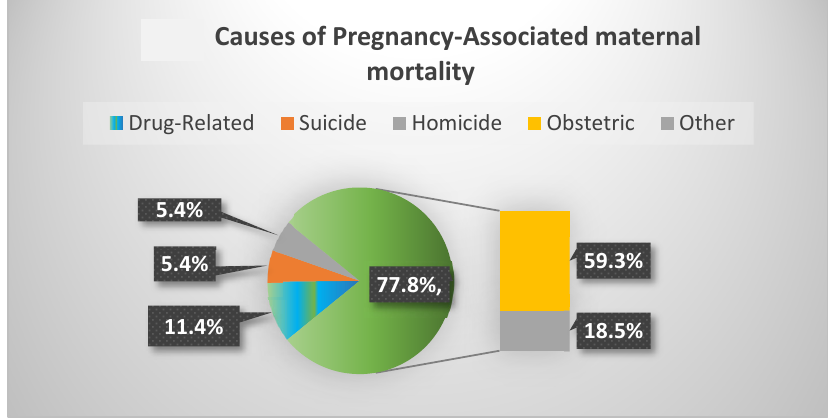
Fig 1. Causes of Pregnancy ‐ Associated maternal